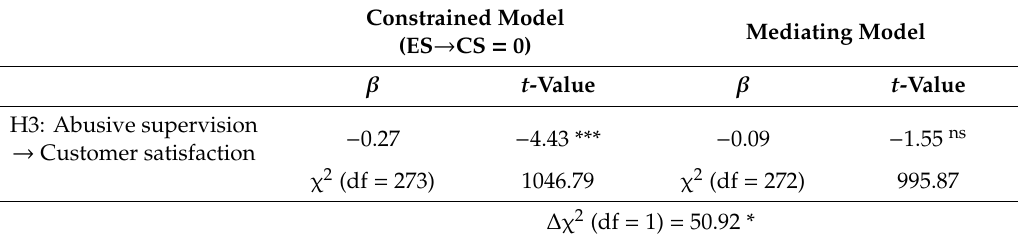
Table 5. Mediating test (full